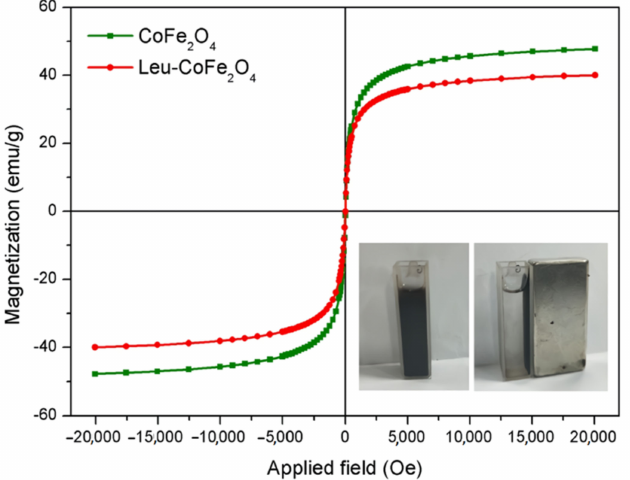
Figure 11. Magnetization curves of bare CoFe 2 O 4 and Leu-coated CoFe 2 O 4 nanoparticles. The inset shows the process of dispersion and magnetic separation. Reprinted from [105] with permission of Elsevier provided by Copyright Clearance